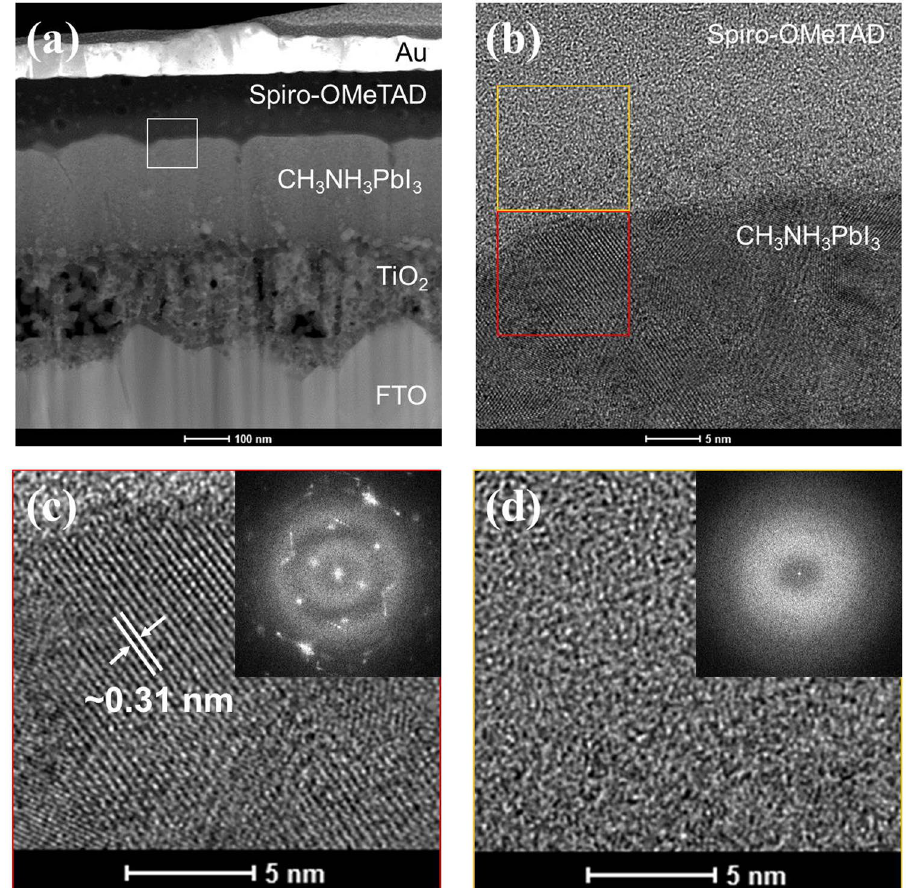
Figure 5. ( a ) TEM micrograph of FTO/TiO 2 /MAPbI 3 /spiro-OMeTAD/Au sample. ( b ) High resolution TEM image of MAPbI 3 /spiro-OMeTAD interface shown in ( a ): white square; ( c , d ) highly magnified TEM image of MAPbI 3 and spiro-OMeTAD shown in ( b ): red square and yellow square, respectively. Inset images show the fast Fourier transform